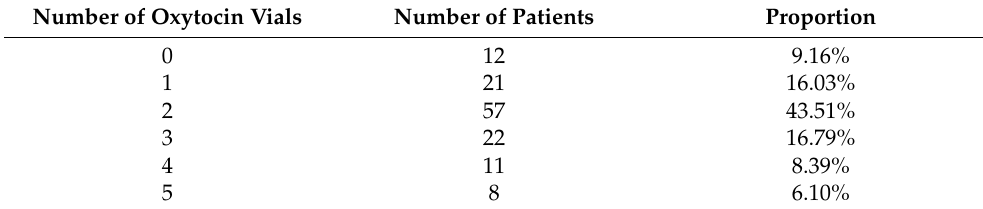
Table 10. Distribution of patients regarding the number of oxytocin vials received during the third stage of labor.